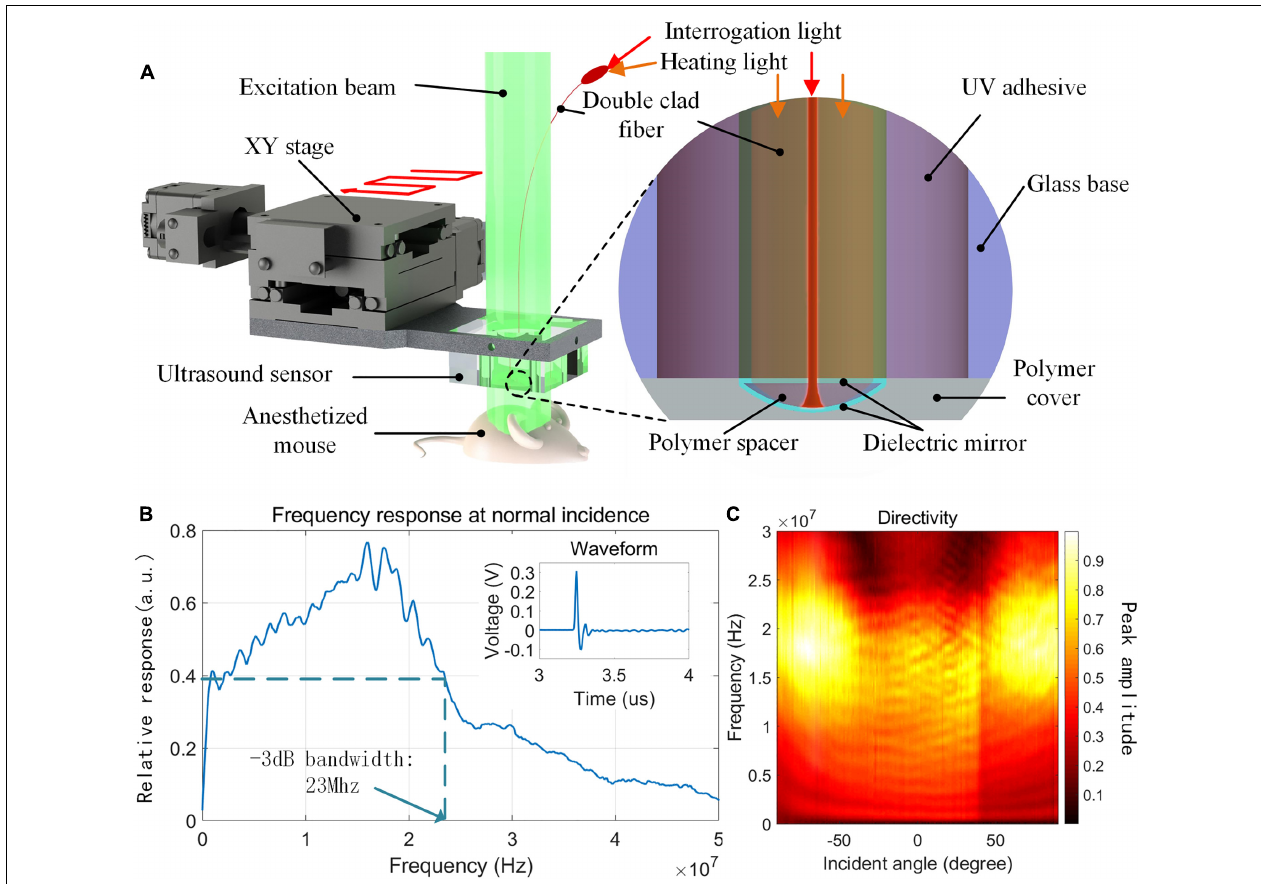
FIGURE 1 | Imaging setup and sensor characterization: (A) schematic of the imaging system setup and the sensor structure. The mouse and the excitation beam were static during imaging while the sensor was raster-scanned by the XY stage. The fiber sensor was inserted into the hole of the glass base and fixed by UV-curing adhesive. (B) Frequency response at normal incidence obtained by Fast Fourier Transform (FFT) of the corresbonding temporal response shown in inset. The –3 dB bandwidth is measured using the dashed lines. (C) Frequency response of the FPI sensor under varying incident angle from –90 to 90 ◦ .